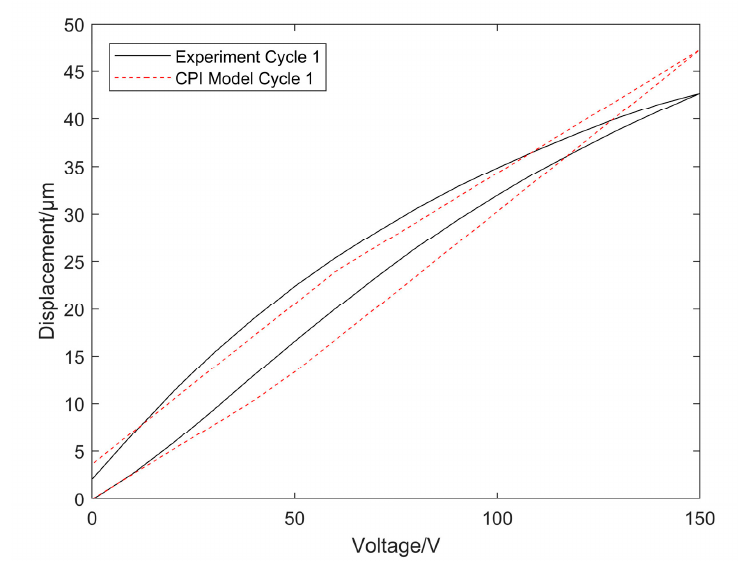
Figure 9. CPI model modeling—the first cycle of experimental data after start-up.